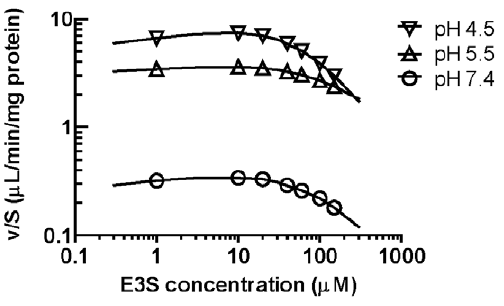
Figure 7. The effect of pH on uptake transport clearance. The uptake clearance n = S ð Þ was estimated using the parameter estimates in Table 1. The solid lines show the best fit to the data using z S n (cid:3) (cid:4) obtained from [ 3 H]-E3S uptake (Fig. n = S ~ V max : S n { 1 (cid:2) S n 50